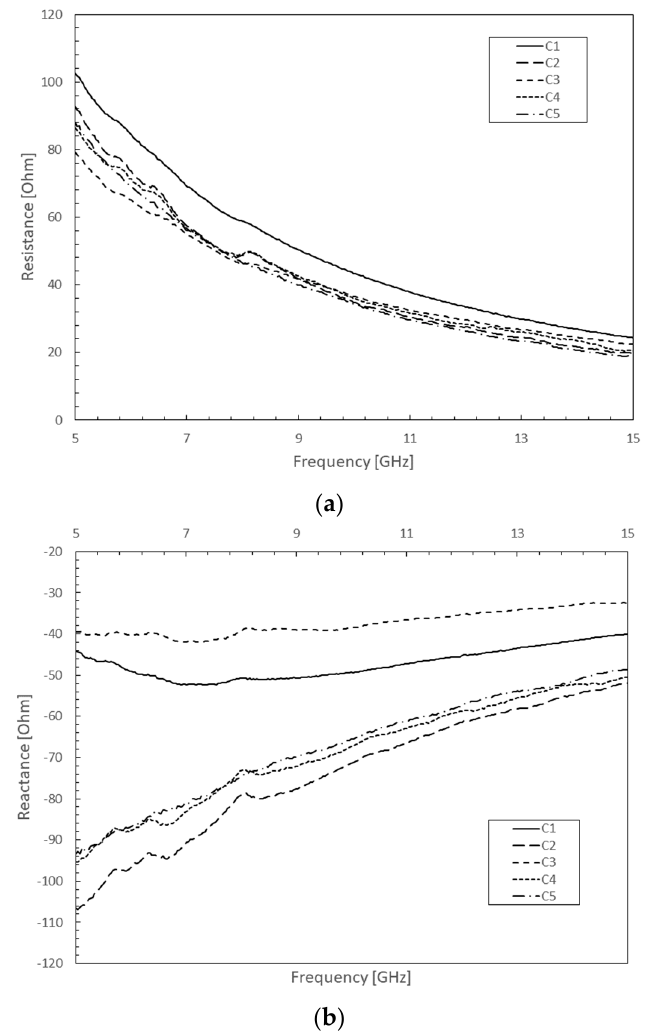
Figure 3. Experimental VA MWCNT bundle impedance extracted from five different CPW devices (C1 to C5) incorporating identical bundle dimensions in the 5–15 GHz frequency band: ( a ) Real part; ( b ) Imaginary part